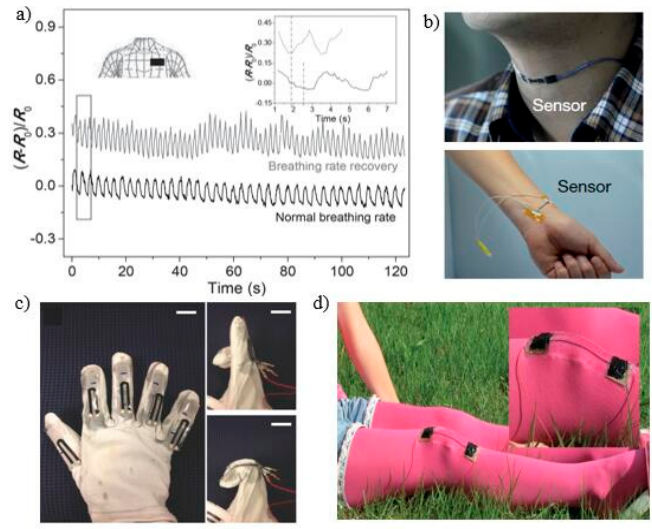
Figure 5. ( a ) The graphene woven fabric (GWF)/PDMS-type sensor’s relative change of resistance of the respiratory in the rest and exercise states, respectively. Reprinted with permission from [72], Copyright John Wiley and Sons, 2014; ( b ) The nanoscale crack sensor attached to skin recording human speech and pulse measurement. Reprinted by permission from [78], Copyright Springer Nature, 2014; ( c ) Data glove with five implanted sensors detected finger moving. Reprinted with permission from [63], Copyright John Wiley and Sons, 2013; ( d ) A wearable carbon nanotube strain sensor integrated into a stocking to detect knee motion. Reprinted with permission from [46], Copyright Springer Nature, 2011.